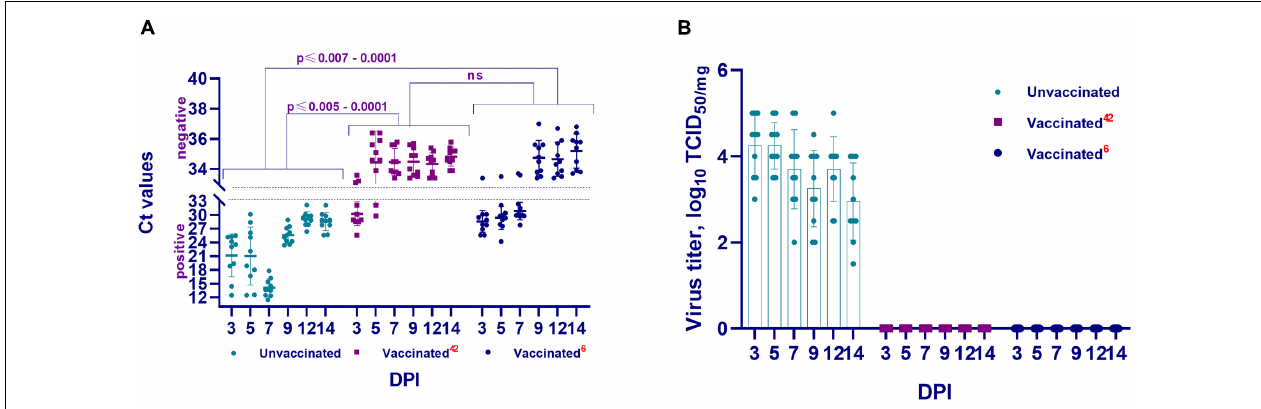
FIGURE 6 | The presence and concentration of virulent virus in the lungs of vaccinated and unvaccinated hamsters. This figure shows data from the 3rd, 5th, 7th, 9th, 12th, and 14th DPI with the wild homologous SARS-CoV-2 virus, specifically the genomic RNA in the lungs (A) , and virus isolation from the lungs in Vero cells. (B) Ct values between 10 and 33 are positive, while Ct values ≥ 33.1 are negative; 42 indicates the vaccinated group at 42 days after vaccination; 6 indicates the vaccinated group challenged 6 months after vaccination; ns indicates no significance; DPI, days post infection.